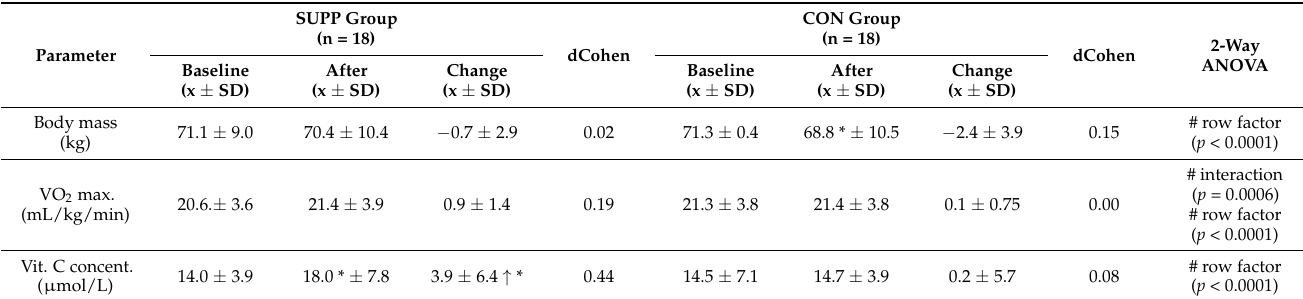
Table 1. Changes in body mass, VO 2 max, and vitamin C concentration in tested groups before and after 6 weeks of